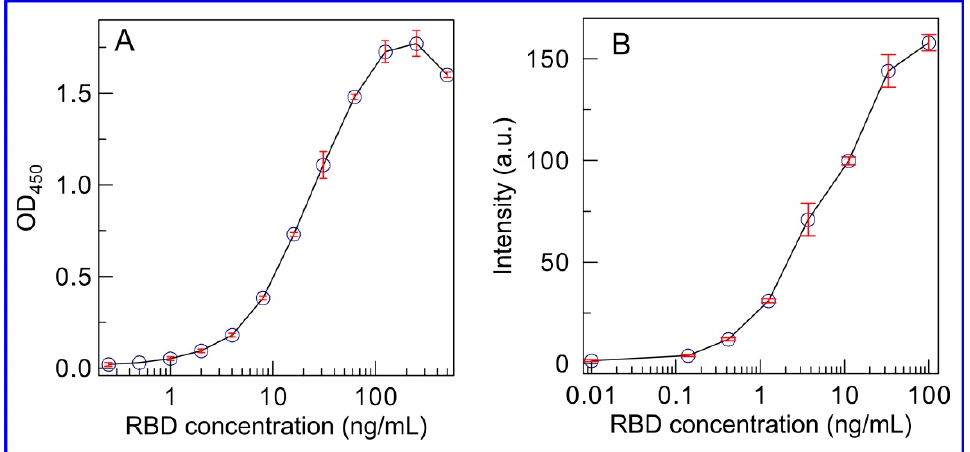
Figure 6. Calibration curves for spike RBD protein using ELISA ( A ) and standard AuNP-based LFIA ( B ). The error bars indicate the STD for three measurements.